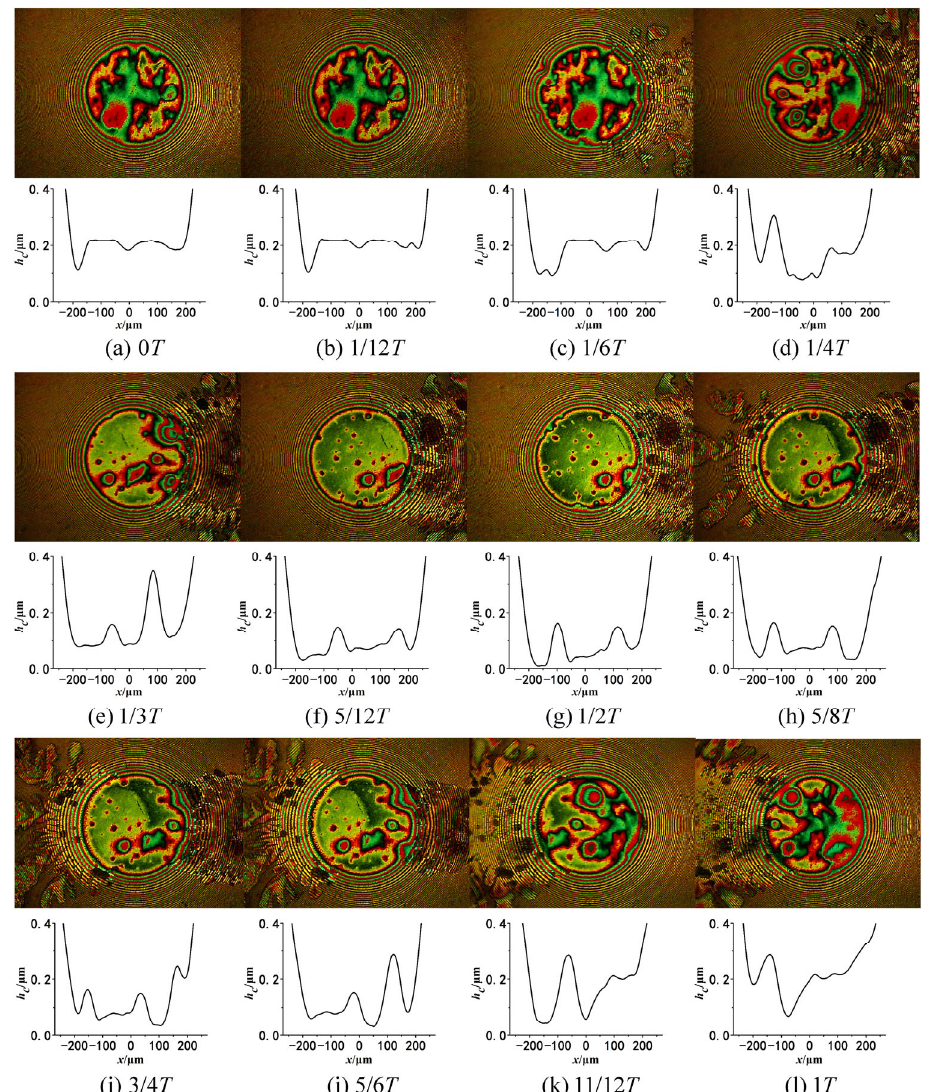
Fig. 16 Interferograms and midsection film thickness during 1st cycle under pure rolling reciprocating motion ( v max = 0.01 m/s, w = 50 N, T = 0.3 s, L = 0.75